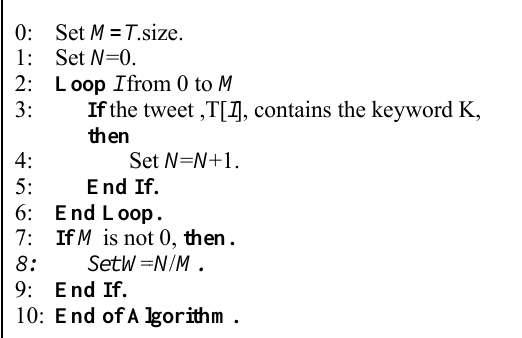
Fig. 3 sho which has m node is not a from the list node